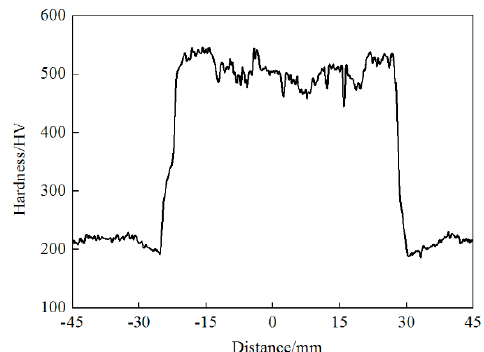
Figure 5. Hardness distribution.